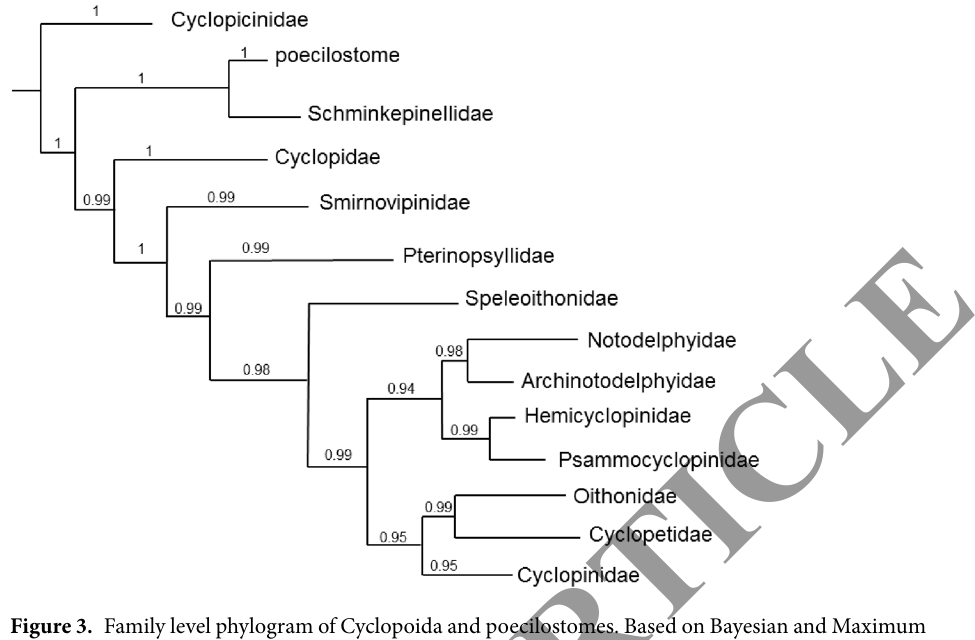
Figure 3. Family level phylogram of Cyclopoida and poecilostomes. Based on Bayesian and Maximum Likelihood analyses of 18S and 28S rRNA, H3 histone protein and COI mtDNA. Nodal support shows posterior probabilities and bootstrap